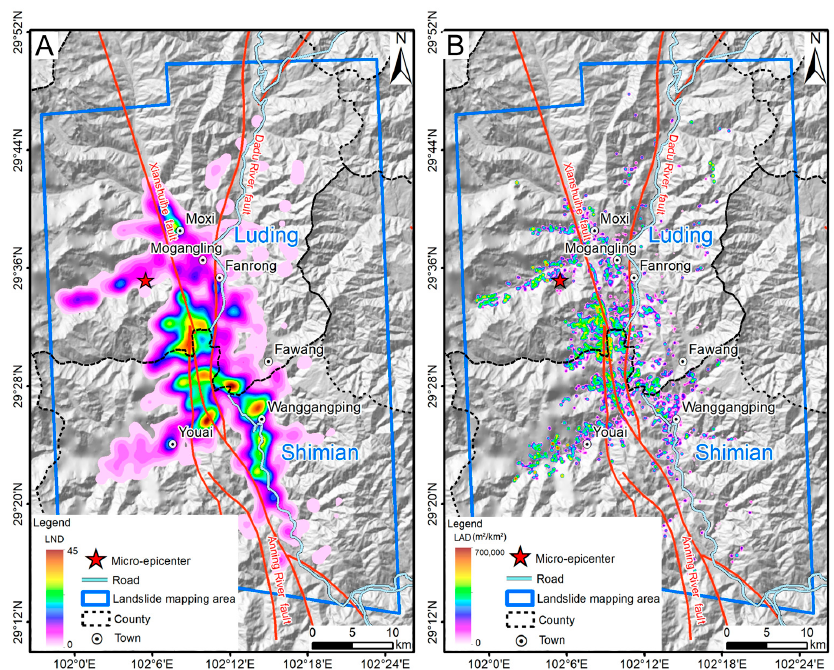
Figure 5. Regional distribution of the coseismic landslides caused by the 2022 Luding event. ( A ) LND; ( B ) LAD.